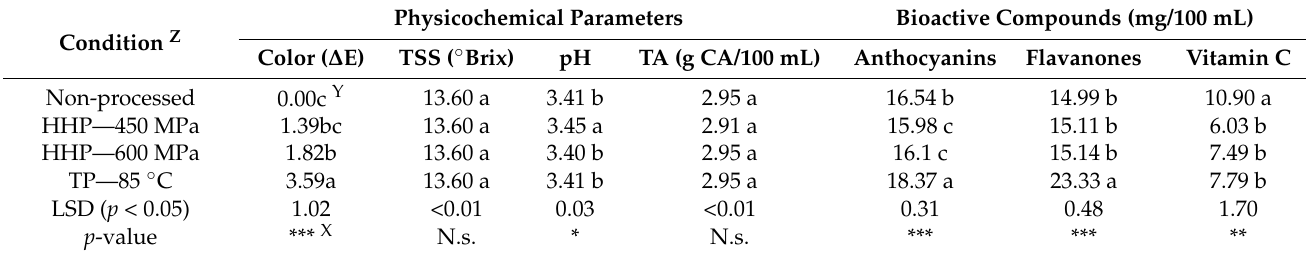
Table 2. Physicochemical parameters and antioxidant biomolecules of non-processed, pressurized, and pasteurized citrus- maqui beverages at zero time of